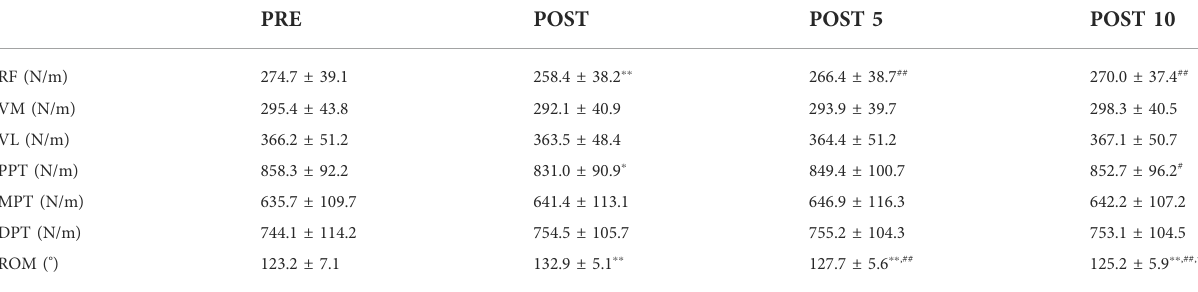
TABLE 2 Changes in RF, VM, VL, PPT, MPT, and DPT stiffness and knee fl exion ROM before and after the static stretching intervention (Mean ± SD).